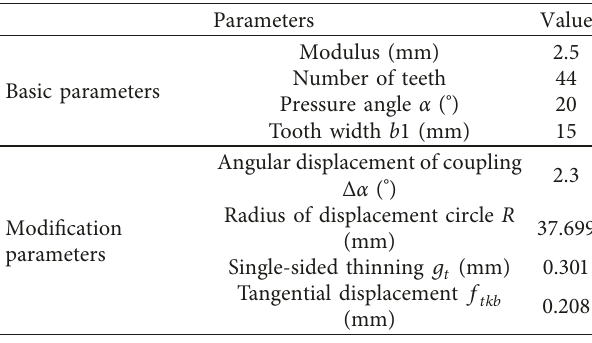
Table 2: Tooth profile parameters of crown gear